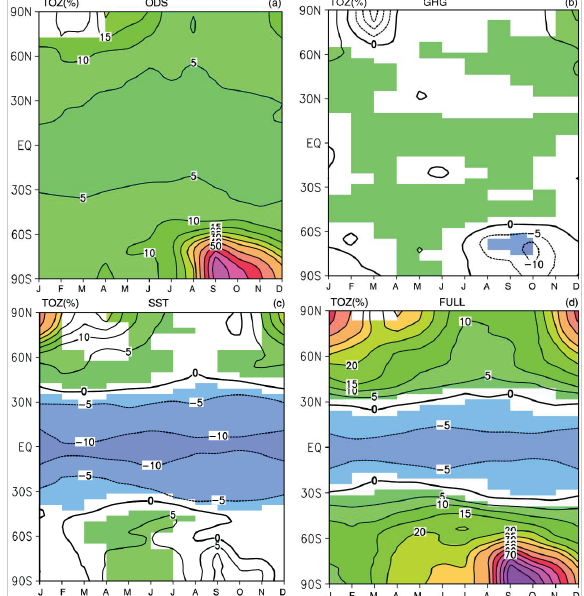
Fig. 4. Zonal and ensemble mean changes of the total column ozone (%) from 2000 to 2100 caused by (a) ODS; (b) GHG; (c) SST/SI; (d) all factors (ODS, GHG, and SST/SI). Color pattern indicates the regions where the changes are judged statistically significant at or better than 5% level. Positive changes are shown in reddish colors while small or negative changes are colored in